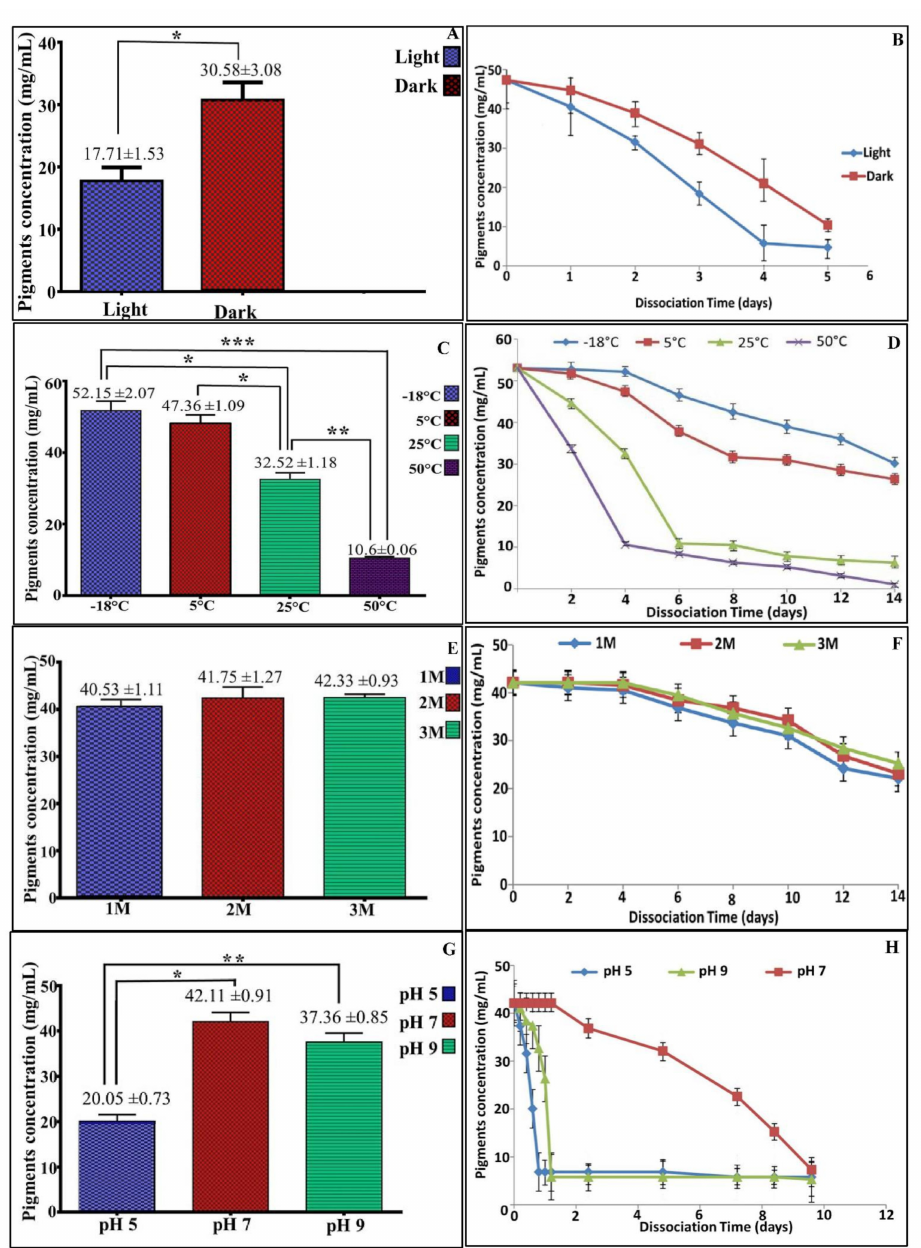
Figure 6. Stability of pigments under different conditions. ( A , B ) Effect of light and dark, ( C , D ) Effect of different temperatures, ( E , F ) Effect of different NaCl concentrations, ( G , H ) Effect of pH change. All histograms represent mean ± SEM of the data at 96 h of incubation. This comparison considers significantly different at * p < 0.05, ** p < 0.005, *** p <